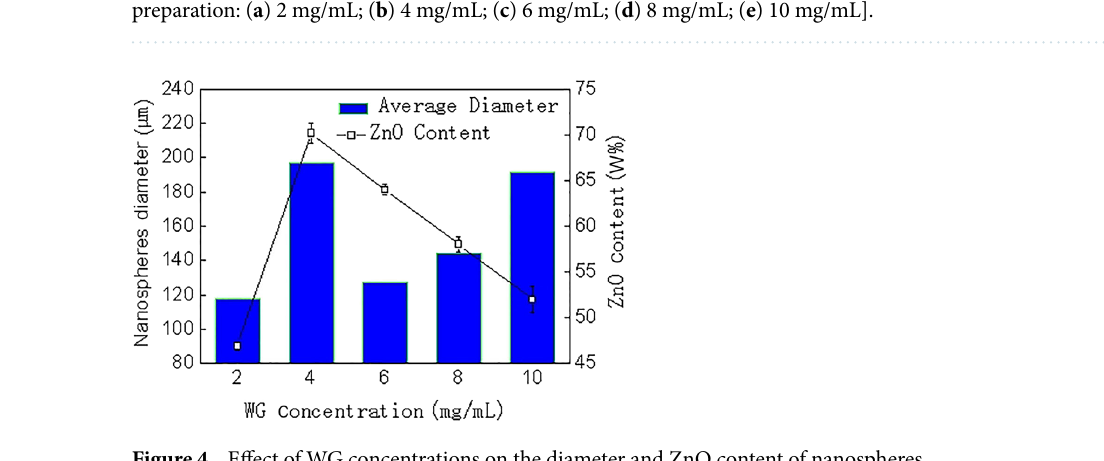
Figure 4. Effect of WG concentrations on the diameter and ZnO content of